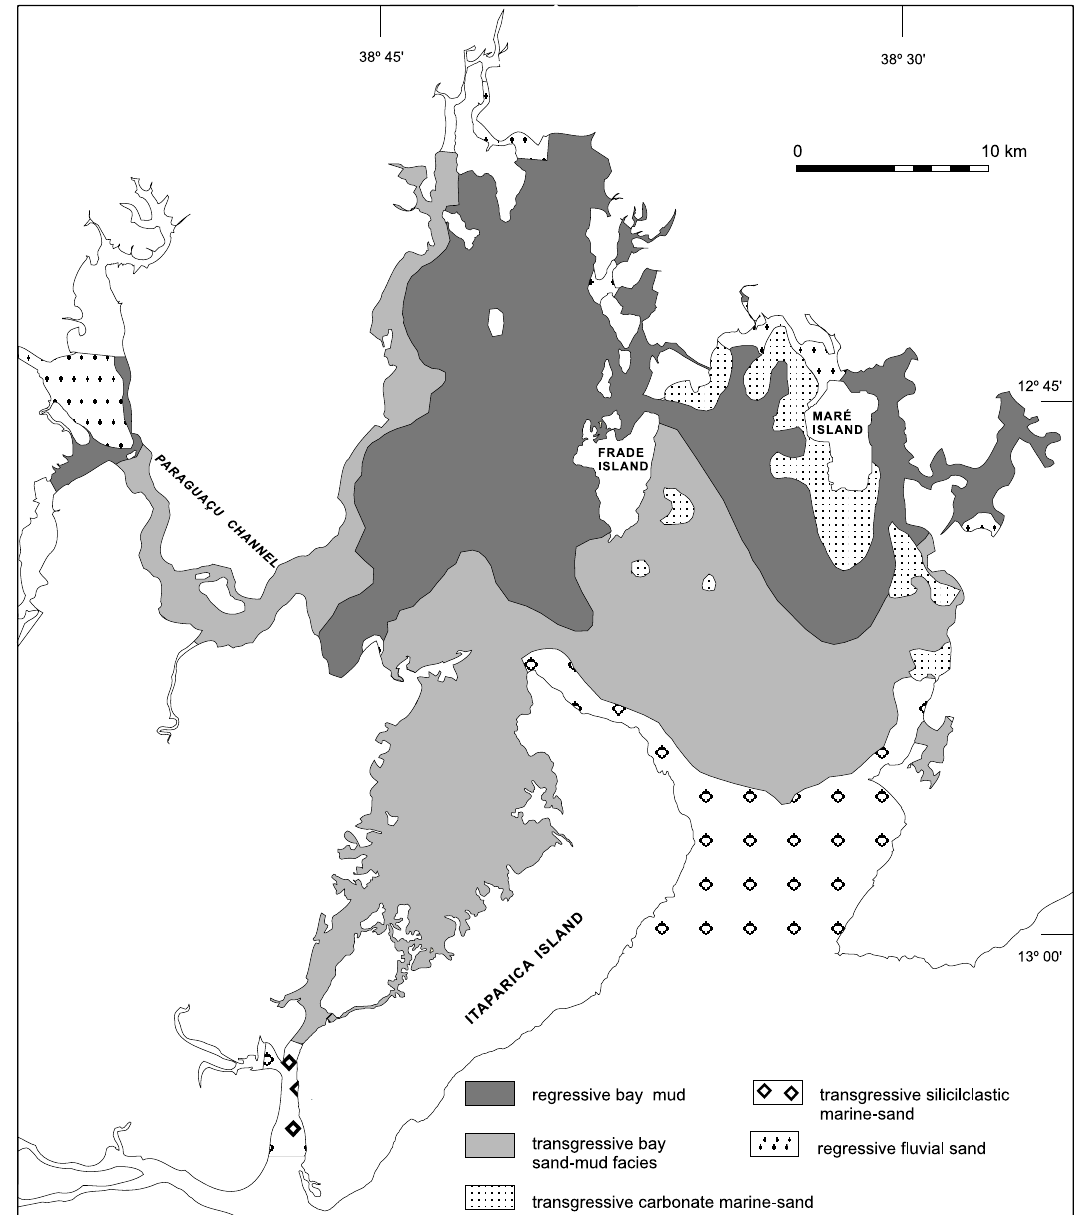
Fig. 7 – Reviewed surface sedimentary facies inside the